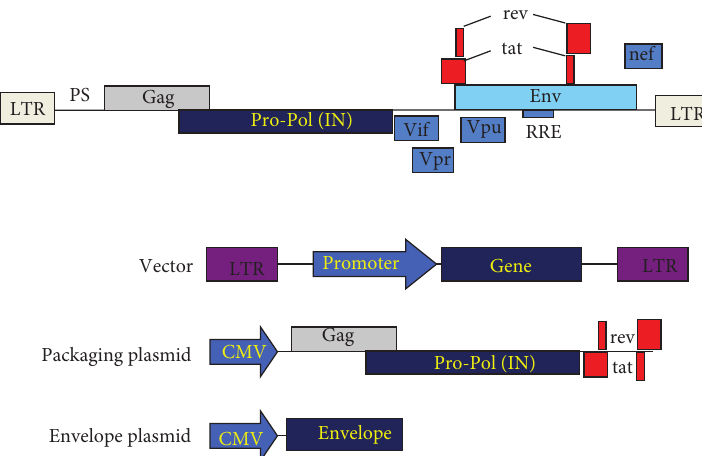
F 3: Engineering of the lentivector gene transfer system. e HIV-1 genome organisation is shown on the top, from 5